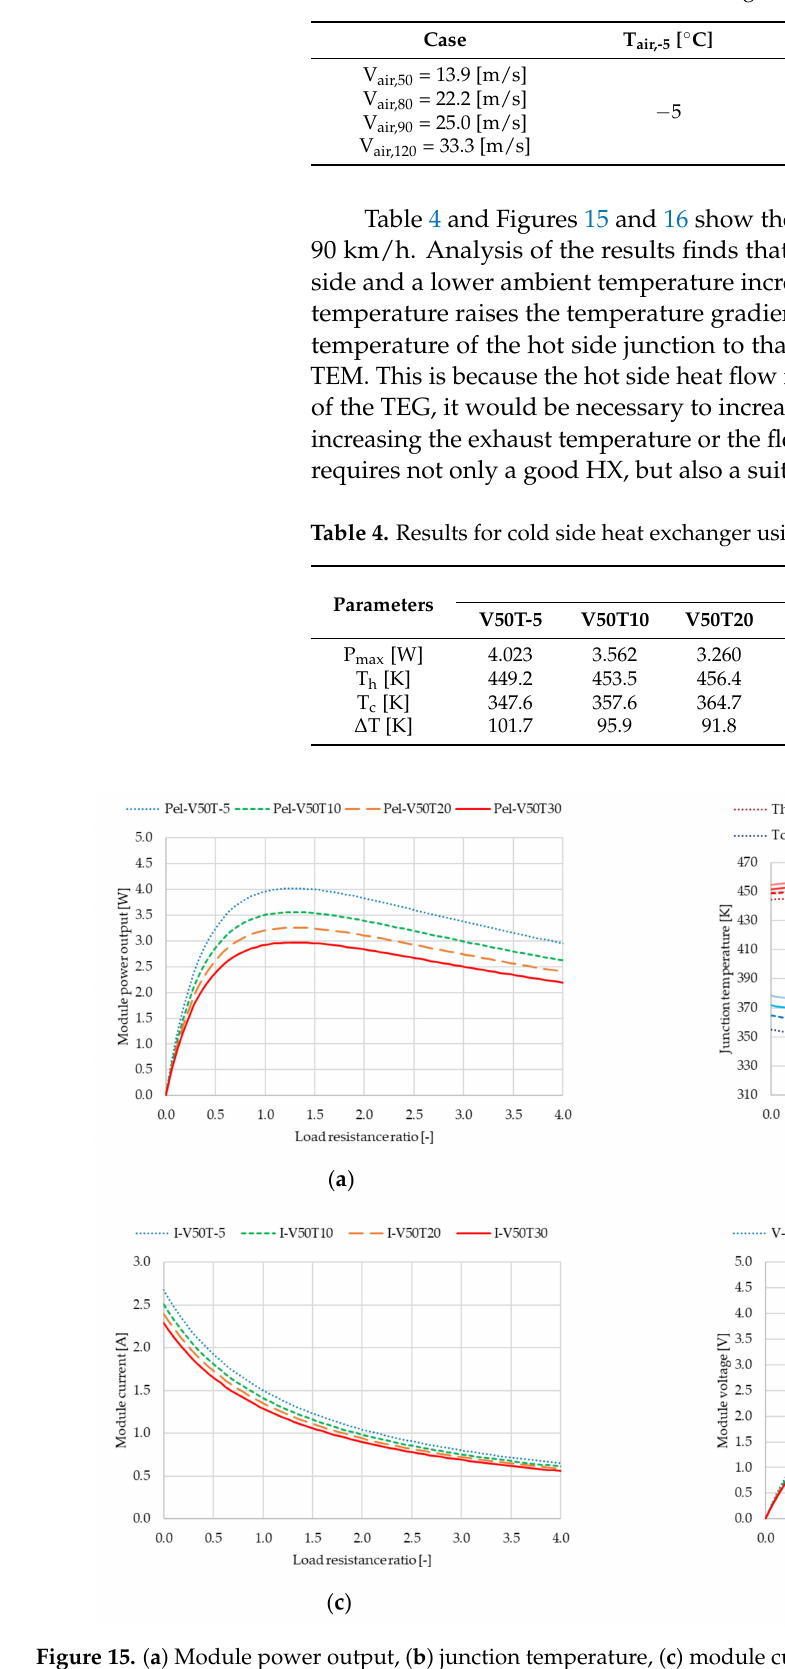
Table 3. Test cases for cold side heat exchanger using air as cooling fluid.